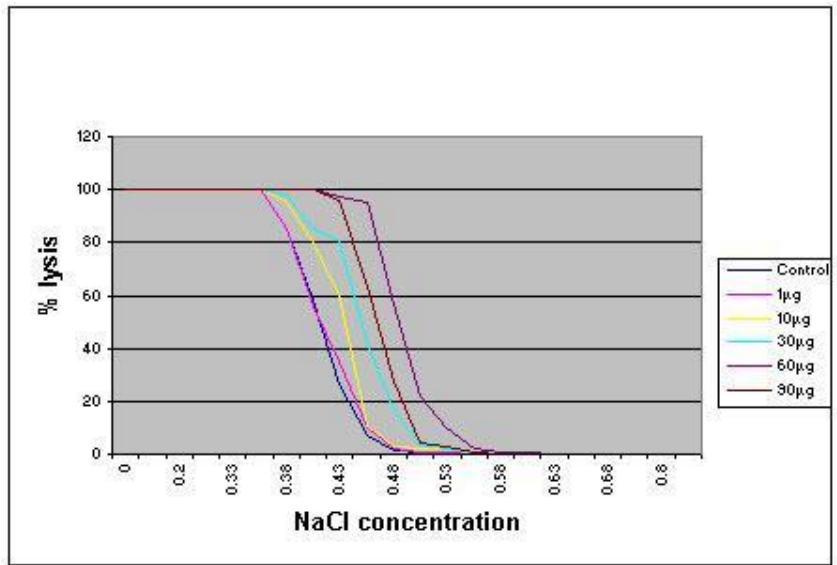
Figure 1. In vitro osmotic fragility of rabbits’ red blood cells incubated at increasing concentrations of NaCl and exposed to various concentrations of H. lepturus venom.